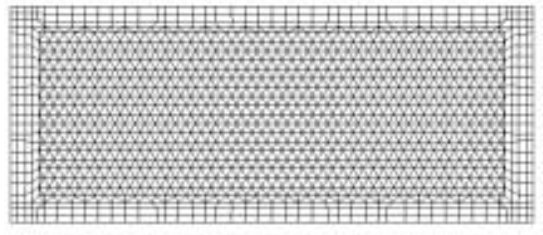
Fig. 2. Finite element model of the box floor for stiffening ribs optimization.